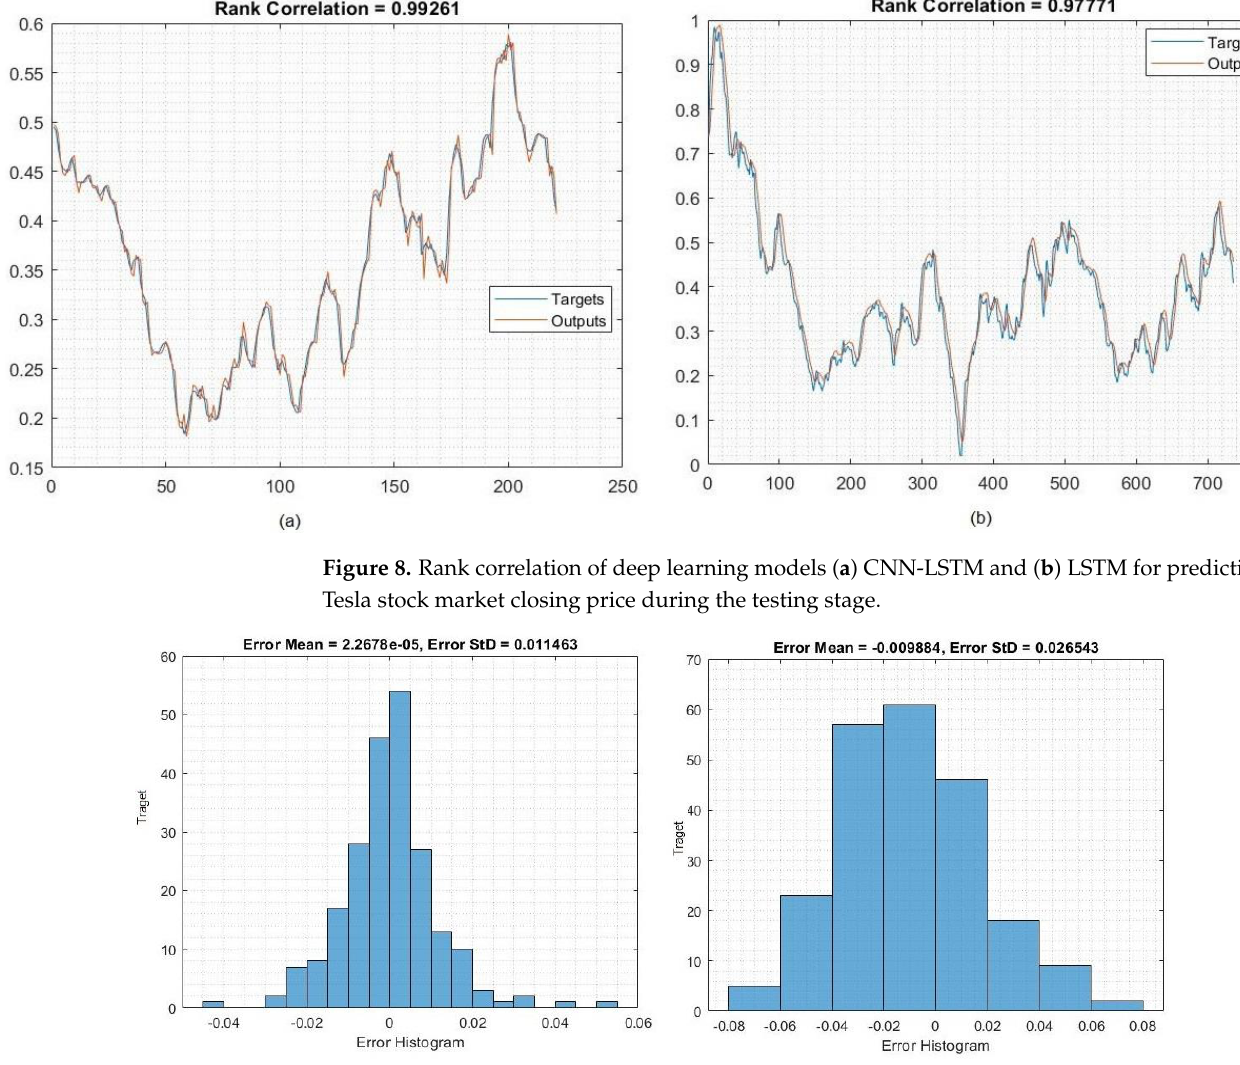
Figure 9. Histogram of deep learning models ( a ) CNN-LSTM and ( b ) LSTM for predicting the Tesla stock market closing price during the testing phase.